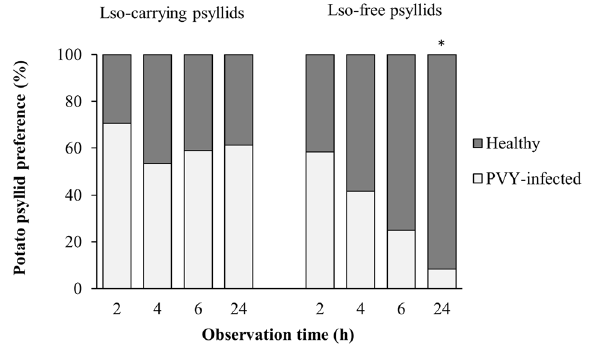
Figure 3. Percentage of Lso-carrying and Lso-free psyllids observed on healthy and PVY-infected tomato plants after 2, 4, 6, and 24 h of exposure. Overall, Lso-carrying psyllids were more likely to settle on healthy tomatoes ( P = 0.014), whereas the Lso-free psyllids settled on PVY-infected plants more frequently ( P = 0.007). Asterisk indicates significant difference within observation time.